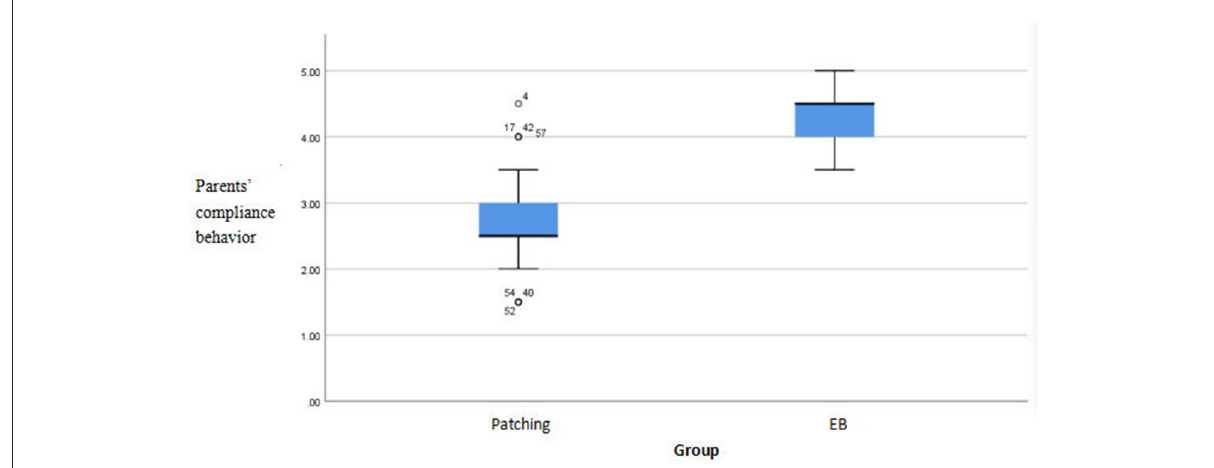
FIGURE6 Box plots of parents’ compliance behavior on two training methods. EB, EYEBIT.